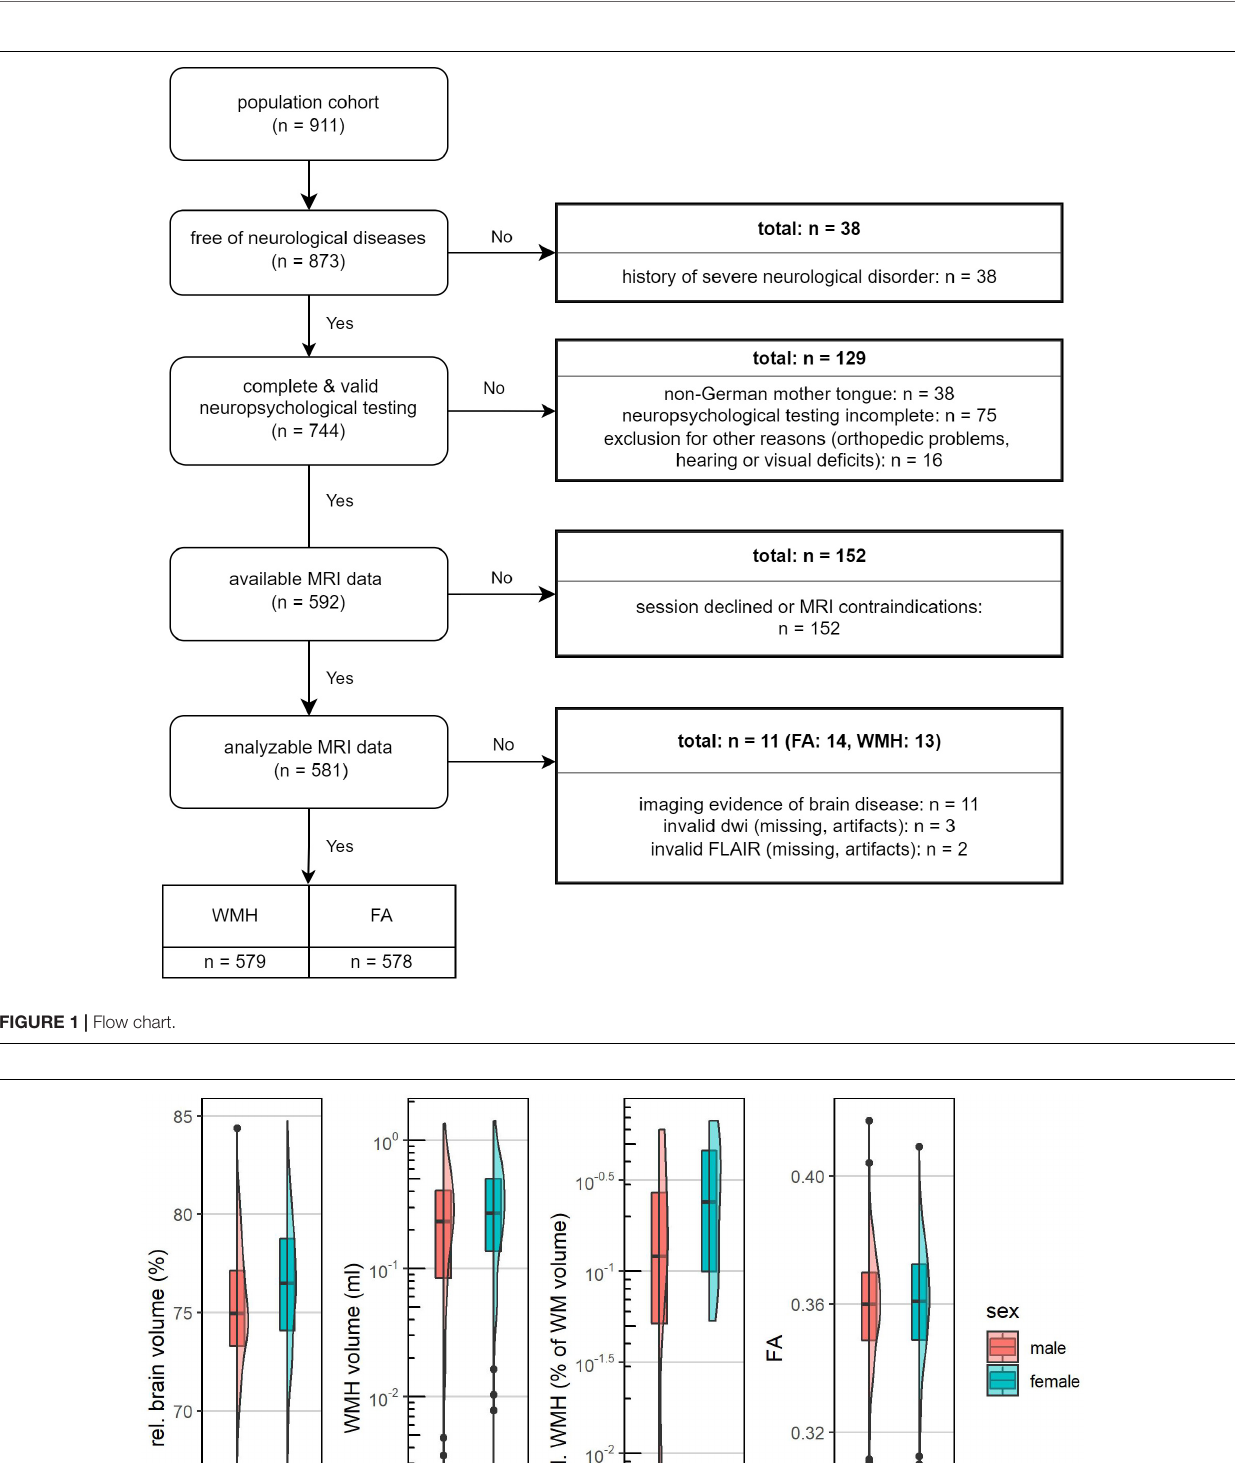
FIGURE 2 | Distributions of MRI markers stratified by